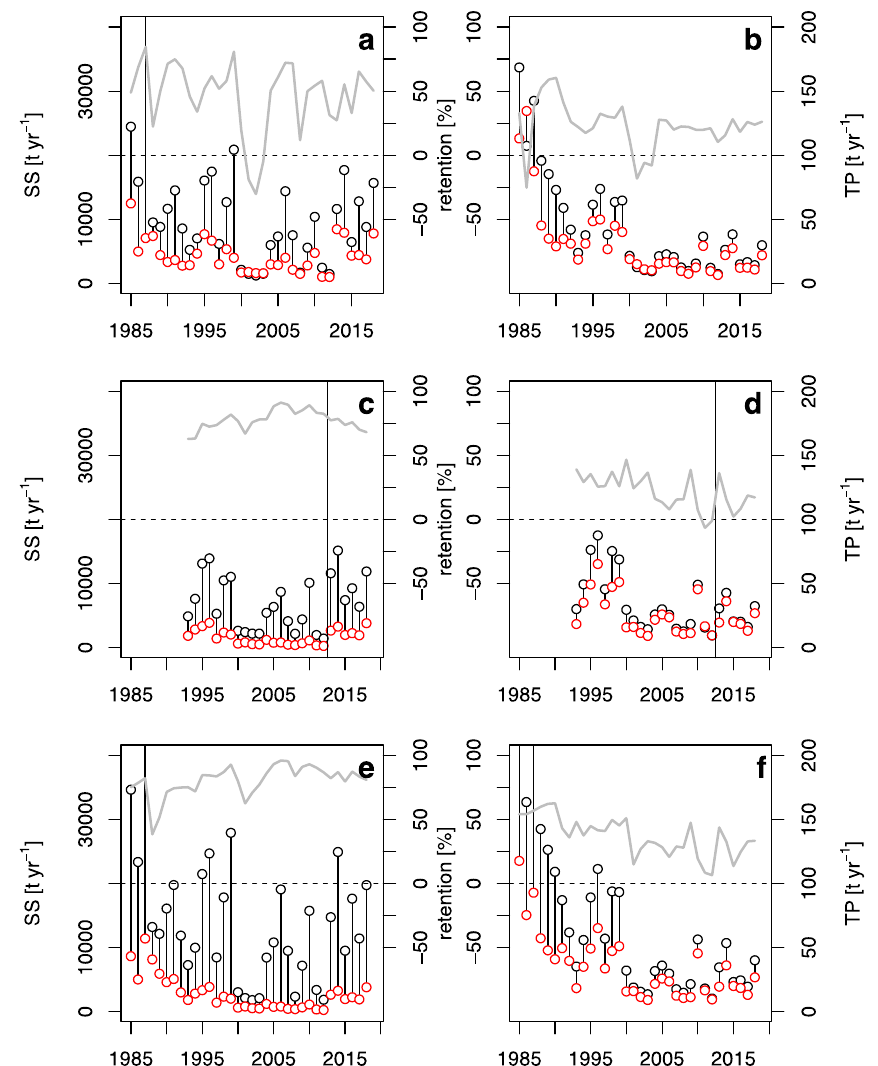
Figure 5. Fluxes (black circles: incoming, red circles: outgoing, connected for clarity) and retentions (gray line) of suspended solids (SS) and total phosphorus (TP) in Lake H ( a , b ), in the area of phase 2 ( c , d ), and in the entire system ( e , f ). In c and d, the vertical line indicates diversion of flow from the Ingói Reeds to Lake F in January 2013.